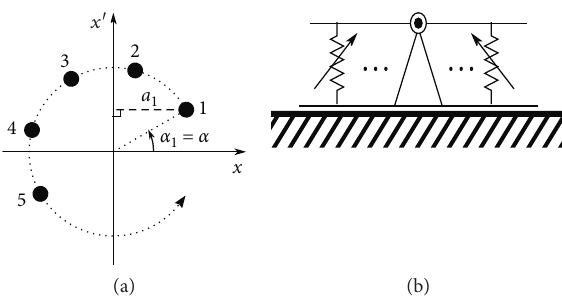
Figure 8: Model of the isolation device: (a) effective arm of force, (b) planar isolation system.